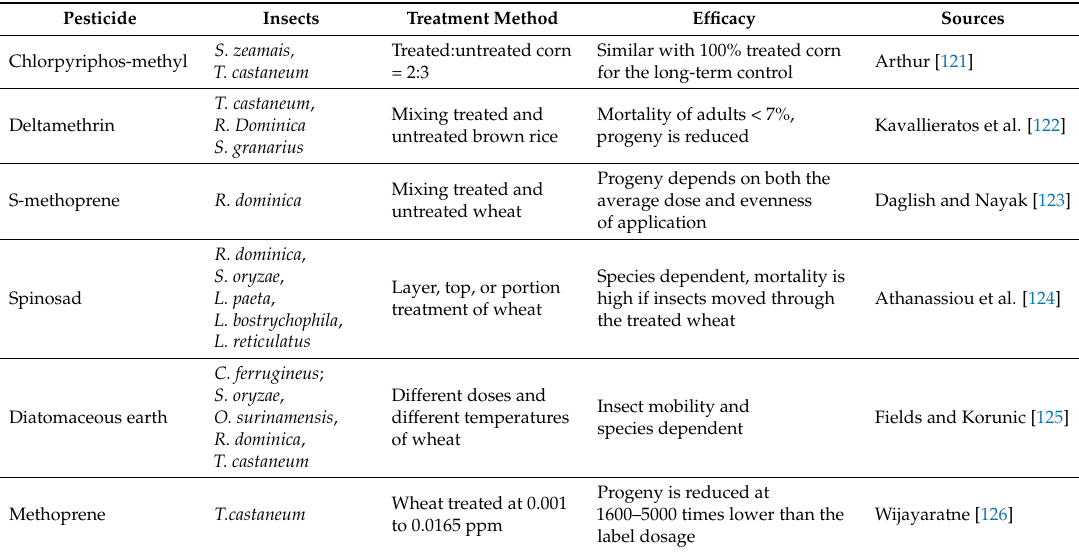
Table 4. Effect of short exposure intervals, low doses, mixing treatments, or partial treatments on